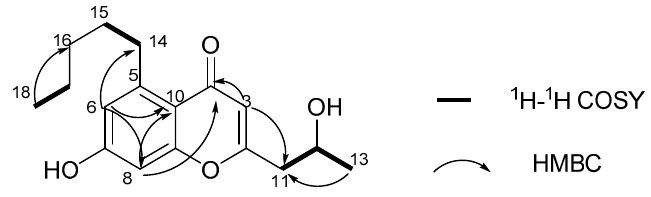
Figure 4. Selected 1 H- 1 H COSY and HMBC correlations of 4 . Table 2. The 1 H- and 13 C-NMR Data for 4 (500/125 MHz, respectively in DMSO- d 6 , δ ppm, J in Hz).